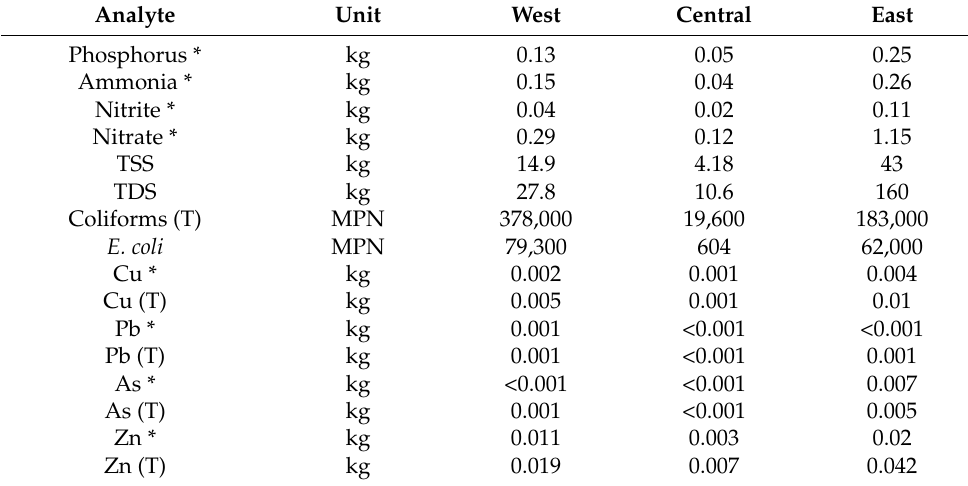
Table 8. Surface water loading for each contaminant during typical rain events. Values are monthly averages based on flow and storm